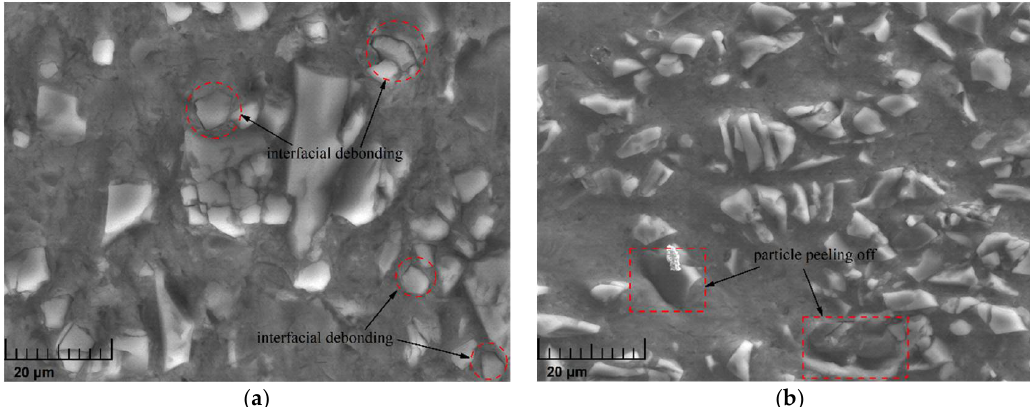
Figure 13. Detailed micromorphology of specimens at 4500 s −1 under the RT condition. ( a ) 20% applied strain; ( b ) 50% applied strain.